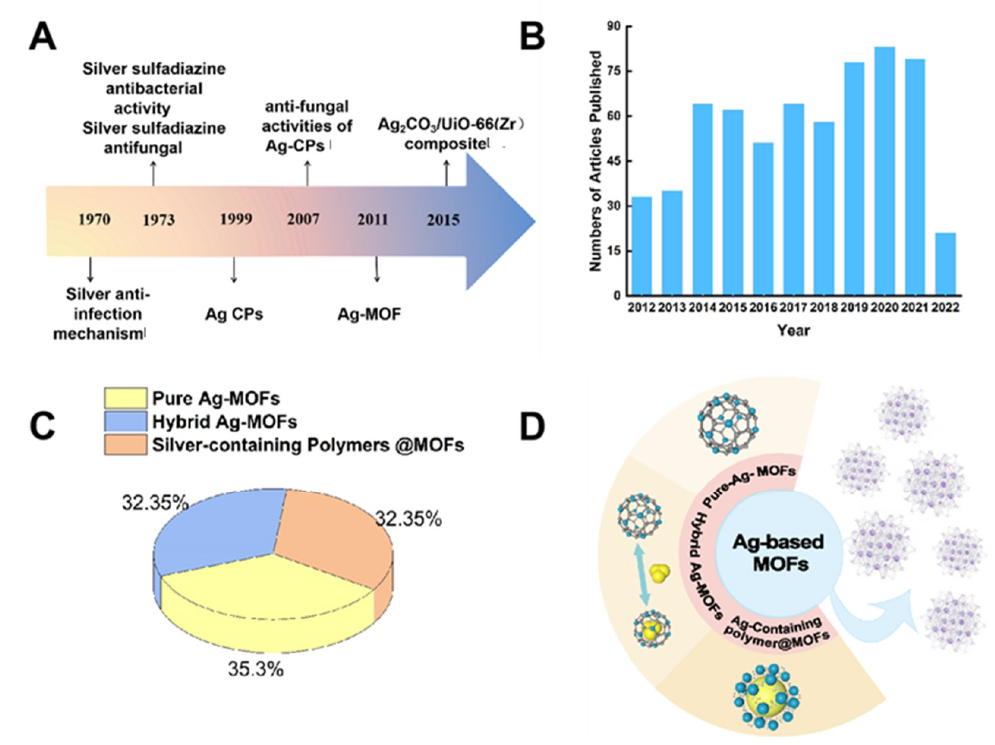
Figure 1. ( A ): Milestones in developing Ag-MOFs for antibacterial activities [89–95]. ( B ): The trend in the numbers of Ag articles published, 2012–2022. ( C ): The proportion of pure Ag-MOFs, hybrid Ag-MOFs, and silver-containing polymer @MOFs. ( D ): The species of Ag-MOFs.